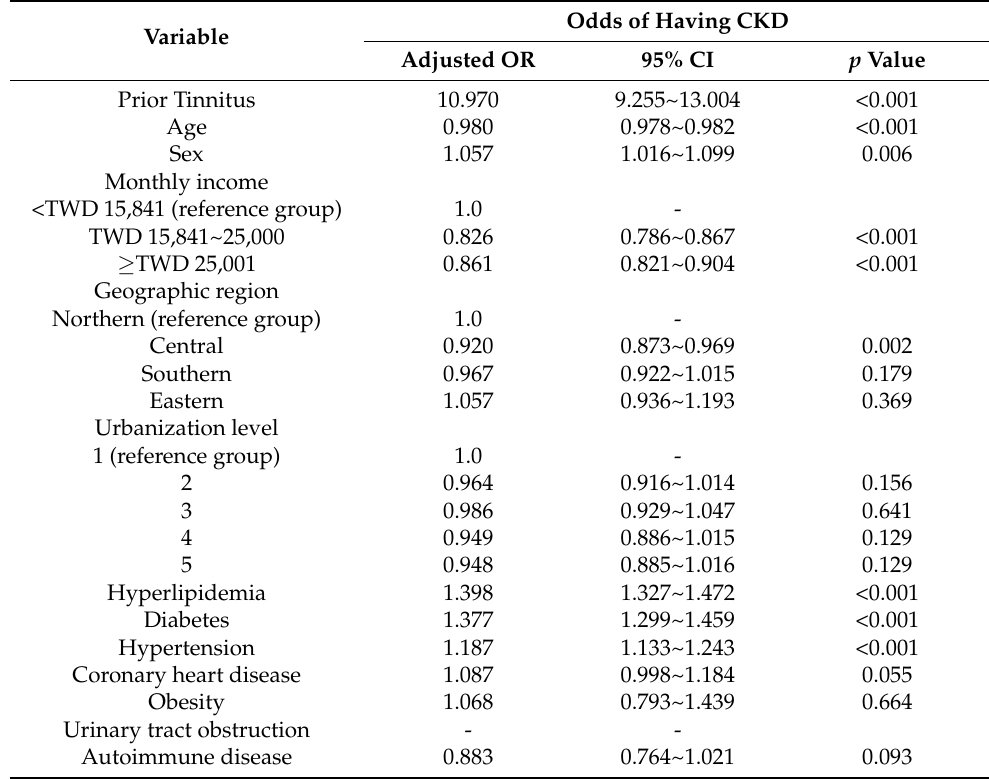
Table 3. Covariate-adjusted odds of prior tinnitus (OR and 95% confidence interval, CIs) among the CKD group vs. controls ( n =